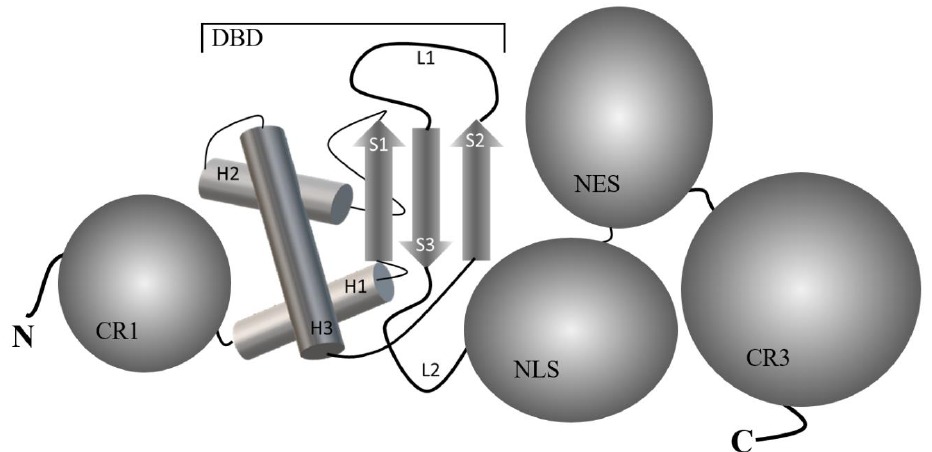
Figure 3. Common five-domain structure/organization of FOXO proteins. The graphical structure of the DNA binding domain (DBD) from FOXO1 has been presented based on the solution NMR method (PDB-ID 6QVW). H1, H2, and H3 are helices, S1, S2, and S3 are strands, and L1 and L2 are wing-like loops. CR1 and CR2 depict N-terminal and C-terminal region domains, respectively. Nuclear localization signal (NLS) and nuclear export sequence (NES) domains are also depicted.